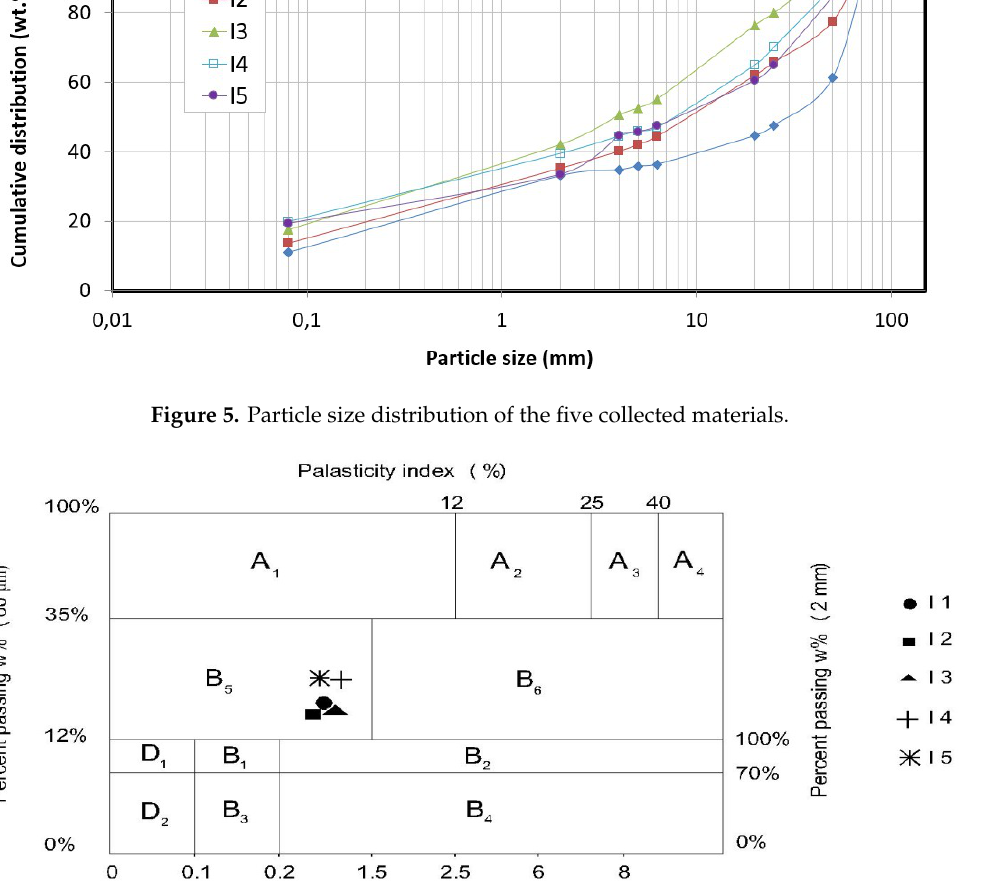
Table 2. Chemical and mineralogical composition of PMWR samples. PMWR Sample